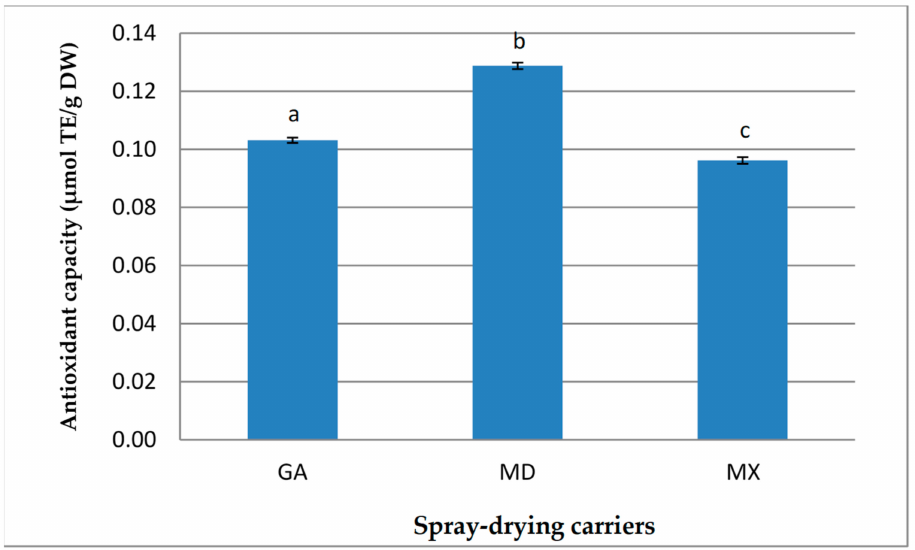
Figure 12. Antioxidant capacity of lemongrass leaf extract powders using different spray-drying carriers. All data are the mean ± SD. Values with different letters are significantly different ( p <